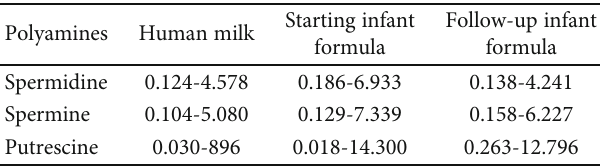
Table 2: Average contents (nmol/mL) of polyamines in term human milk and infant